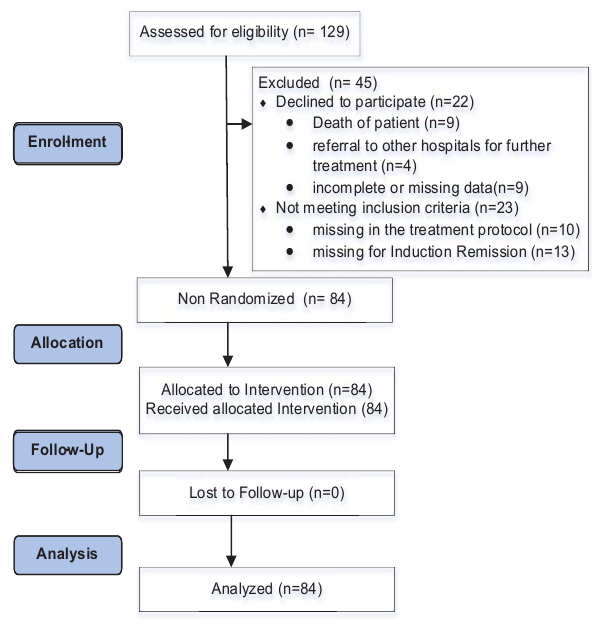
Fig-1: Patients Consort E chart Treatment: Most of the patients were treated with BFM 76/79 Protocols and the remaining patients were treated with other protocols (CALGB, FLAG- TDA, Hyper-CVAD, EURO, COG, T-Cell ALL protocol, and ALL protocol 9111).